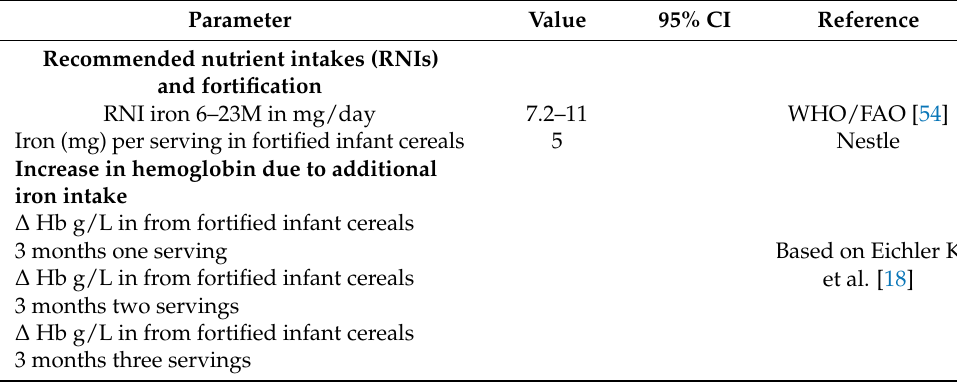
Table A4. Iron intake requirements and the impact of fortified infant cereals on hemoglobin